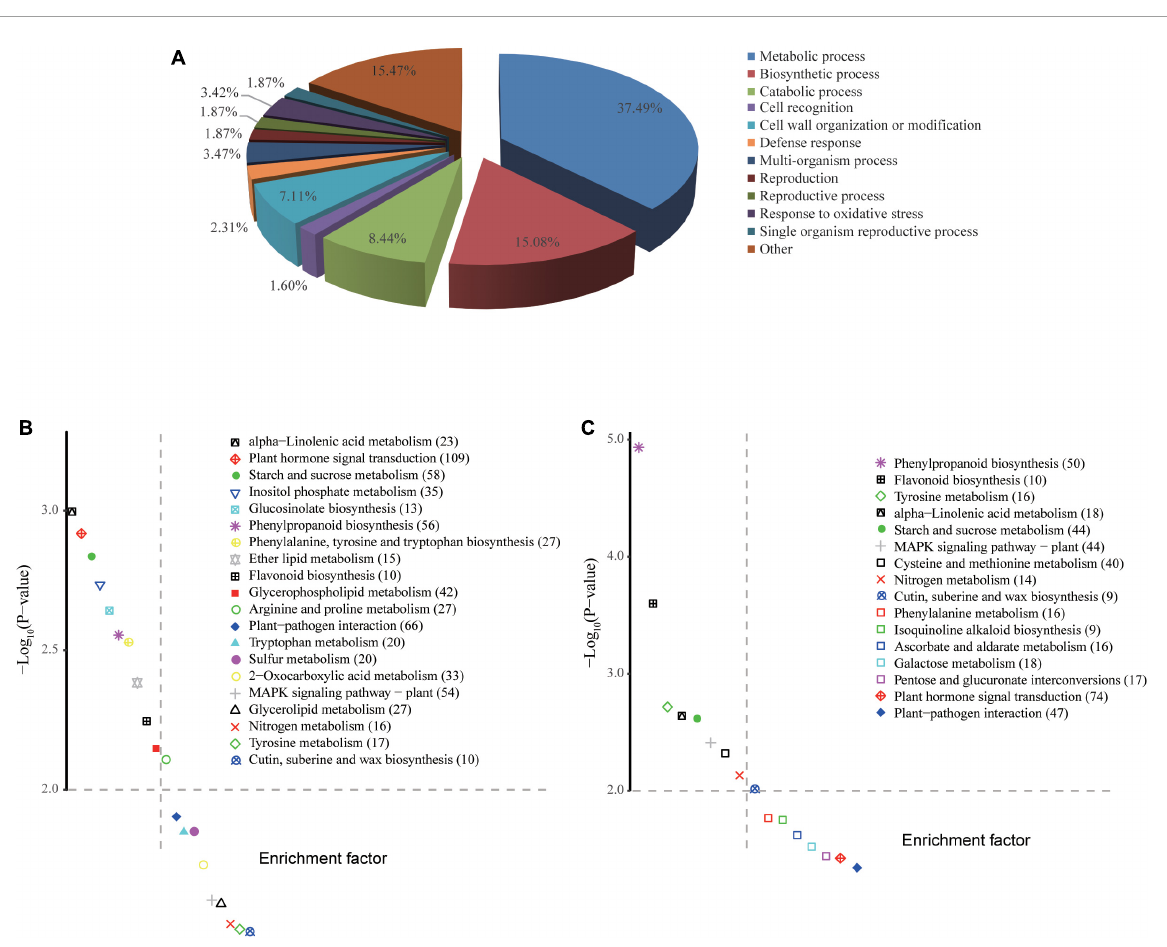
after inoculation in ZS9m Xcc R-1, but in ZS9m Xcc S-1 only